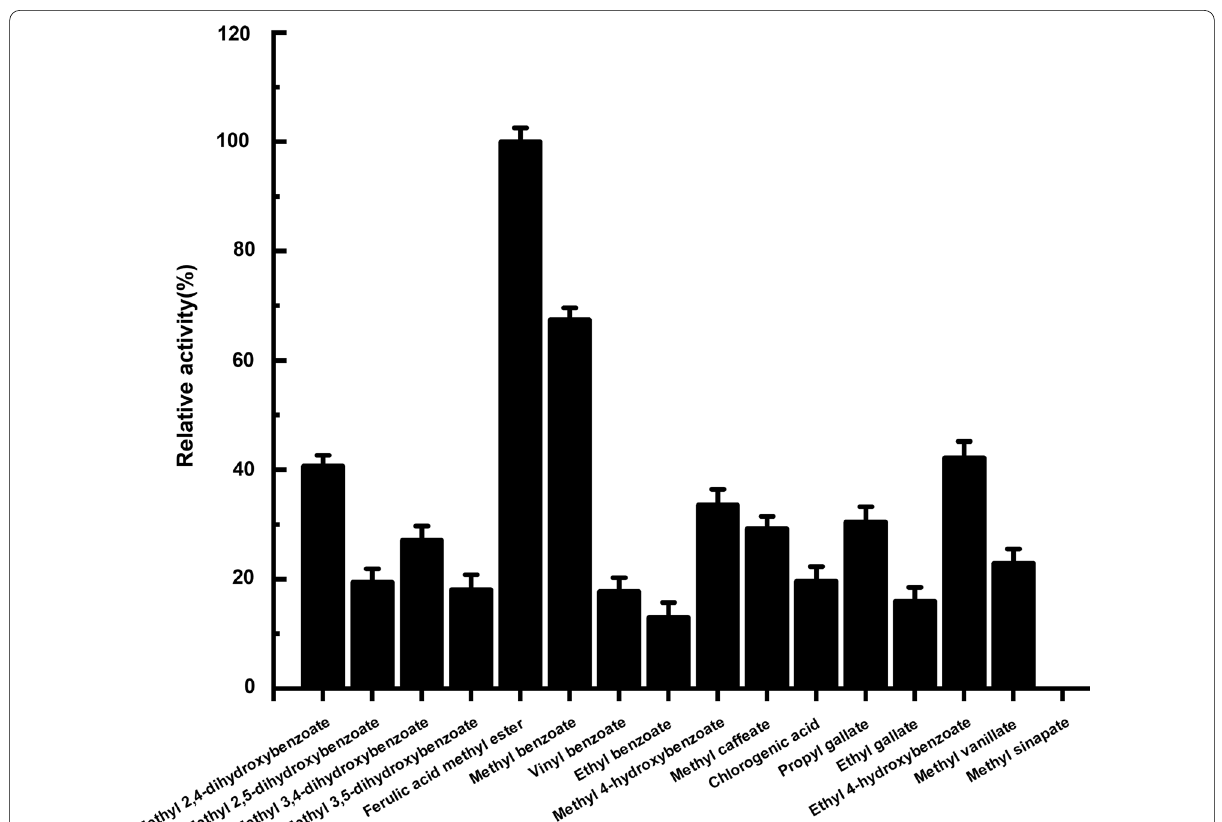
Fig. 7 HPLC analysis of different substrates hydrolyzed by esterase